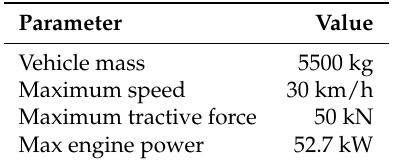
Table 1. Parameters for the reference vehicle.